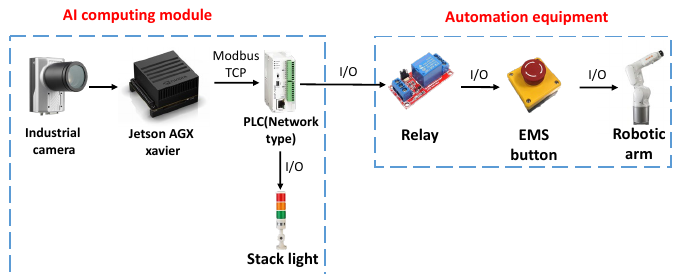
Figure 7. The actual hardware configuration.